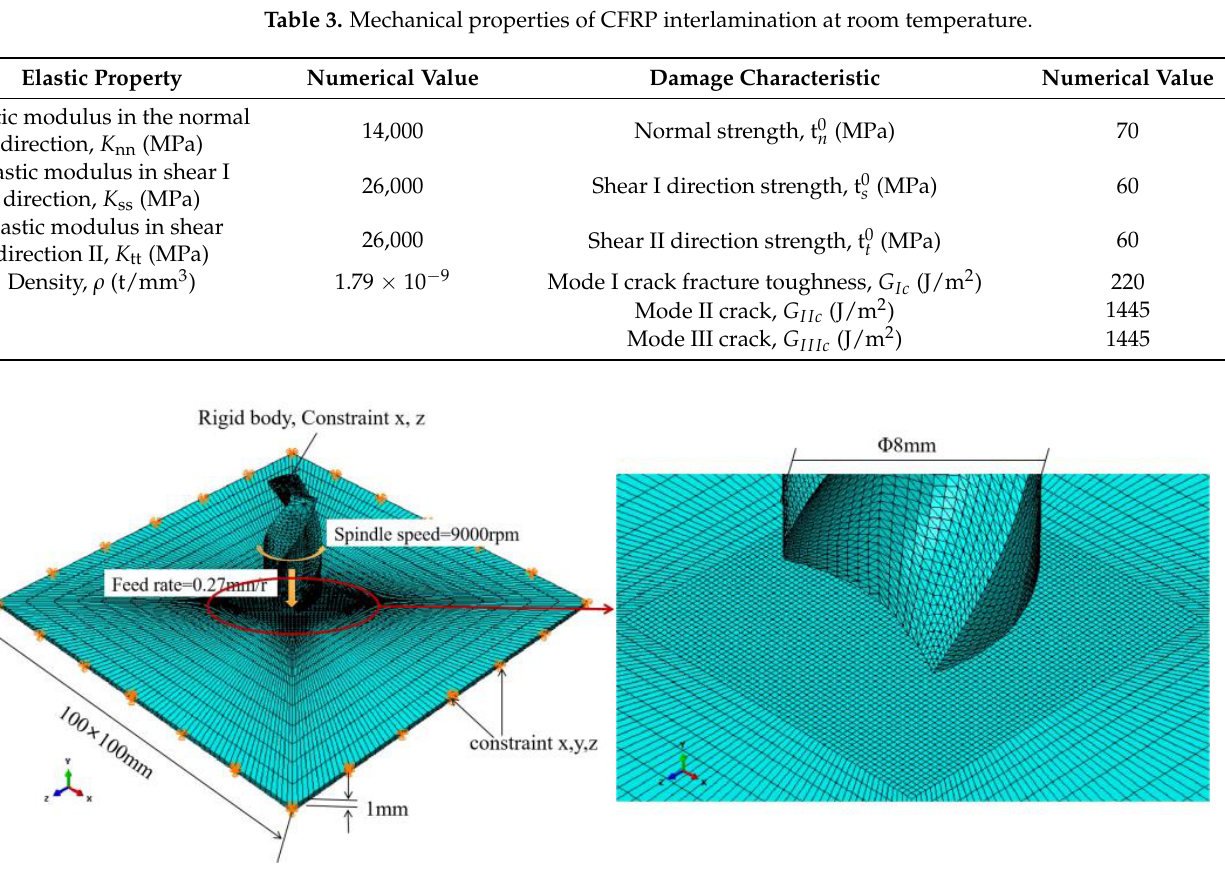
Figure 1. CFRP three-dimensional drilling finite element model. Table 2. Mechanical properties of CFRP at room temperature.